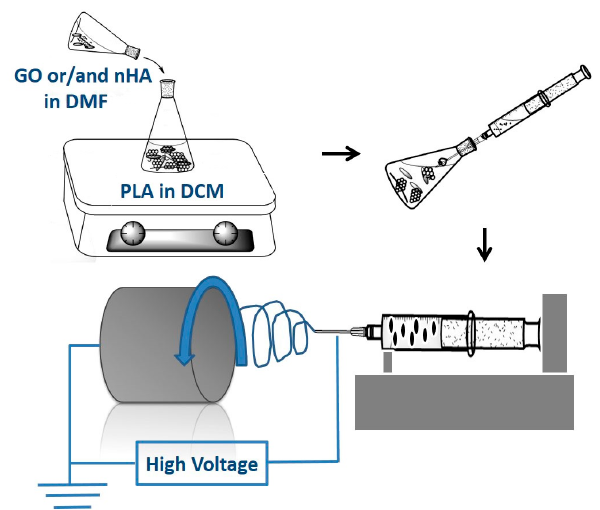
Figure 1. Schematic illustration showing the preparation of electrospun nanocomposite fibrous mats. PLA, polylactic acid; GO, Graphene Oxide; nHA, nanohydroxyapatite rod; DCM, dichloromethane; DMF, N , N